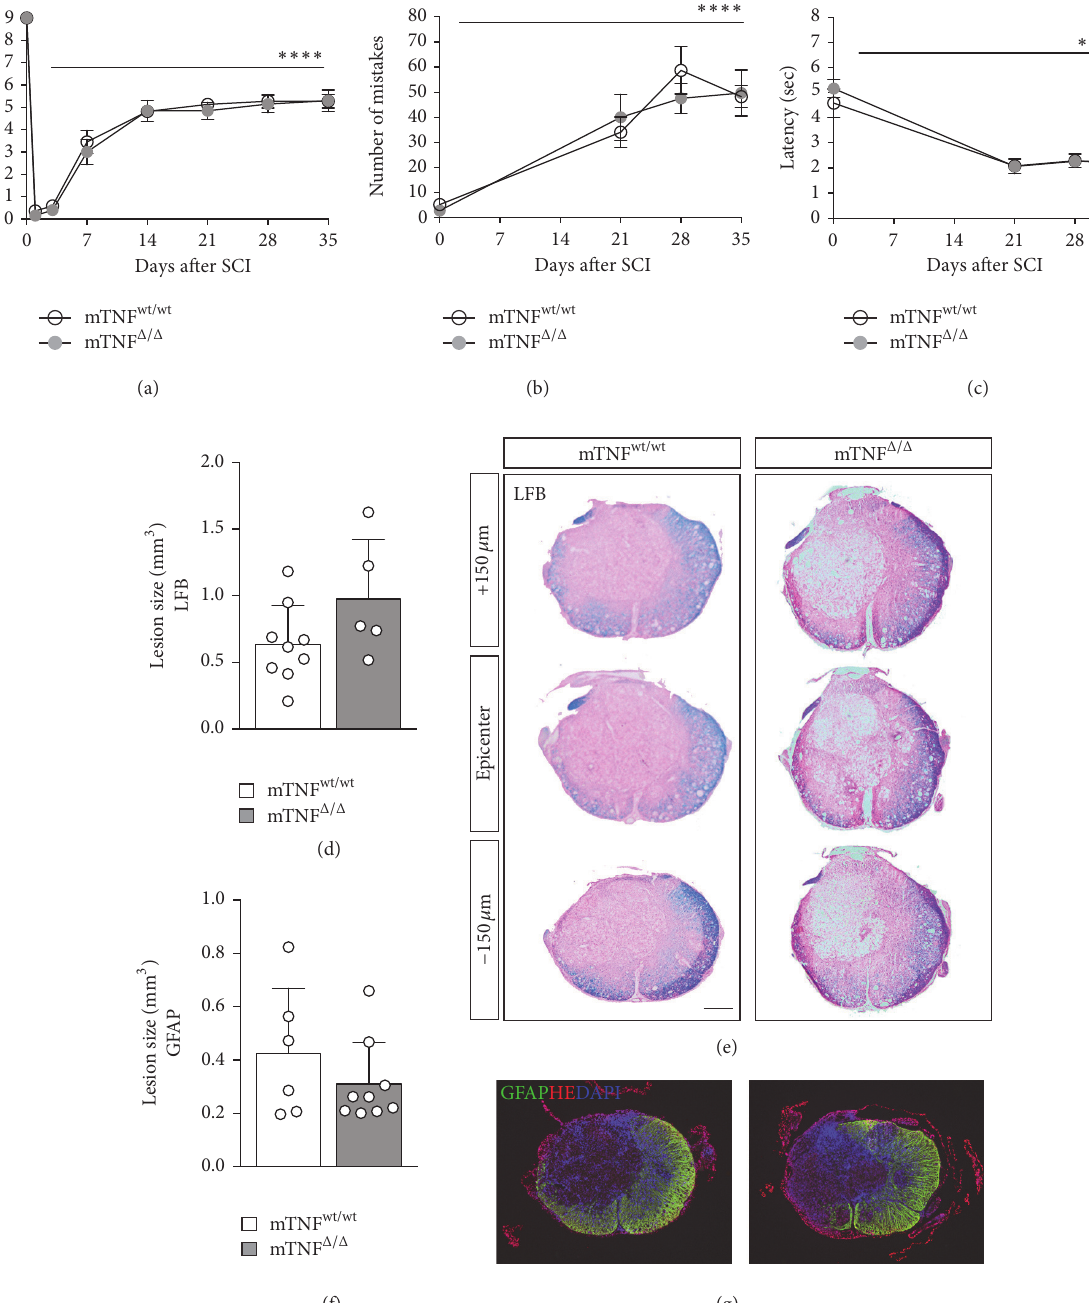
Figure 2: Genetic ablation of solTNF does not affect functional outcome or lesion size after SCI. (a) Analysis of BMS scores in mTNF wt / wt and mTNF Δ/Δ mice showed that genetic ablation of solTNF did not affect BMS scores after SCI. Both groups of mice improved their BMS score over time (two-way RM ANOVA; time ∗∗∗∗ 𝑝 < 0.0001 , 𝐹 3,133 = 295.1 ), 𝑛 = 10 -11mice/group. (b) Rung walk analysis showed that both groups of mice increased their number of mistakes after SCI (two-way RM ANOVA; time ∗∗∗∗ 𝑝 < 0.0001 , 𝐹 3,51 = 27.8 , Tukey’s post hoc ∗∗∗∗ 𝑝 < 0.0001 ), 𝑛 = 9 -10mice/group, and no differences between genotypes were observed. (c) Thermal stimulation using Hargreaves’ test showed no differences in latency time to withdraw paws between genotypes. Both groups decreased latency to remove their paws over timeafterSCI(two-wayRMANOVA;time ∗∗∗∗ 𝑝 < 0.0001 , 𝐹 3,51 = 14.72 ,Tukey’s posthoc ∗∗∗∗ 𝑝 < 0.0001 ), 𝑛 = 9 -10mice/group.(d)Analysis of lesion volumes in Luxol Fast Blue (LFB) stained sections 35 days after SCI showed that lesion size was comparable between mTNF wt / wt and mTNF Δ/Δ mice (Mann–Whitney), 𝑛 = 5 –9 mice/group. (e) Representative LFB-stained thoracic spinal cord sections from mTNF wt / wt and mTNF Δ/Δ mice allowed 35-day survival after SCI. Scale bar: 100 𝜇 m. (f) Analysis of lesion volumes in GFAP-stained sections 35 days after SCI showed that lesion size was comparable between mTNF wt / wt and mTNF Δ/Δ mice (Mann–Whitney), 𝑛 = 5 –9 mice/group. (g) GFAP labeling (green), fluorescent Nissl (red), and DAPI (blue) staining of representative spinal cord sections from mTNF wt / wt and mTNF Δ/Δ mice allowed 35-day survival after SCI. Results are presented as mean ±